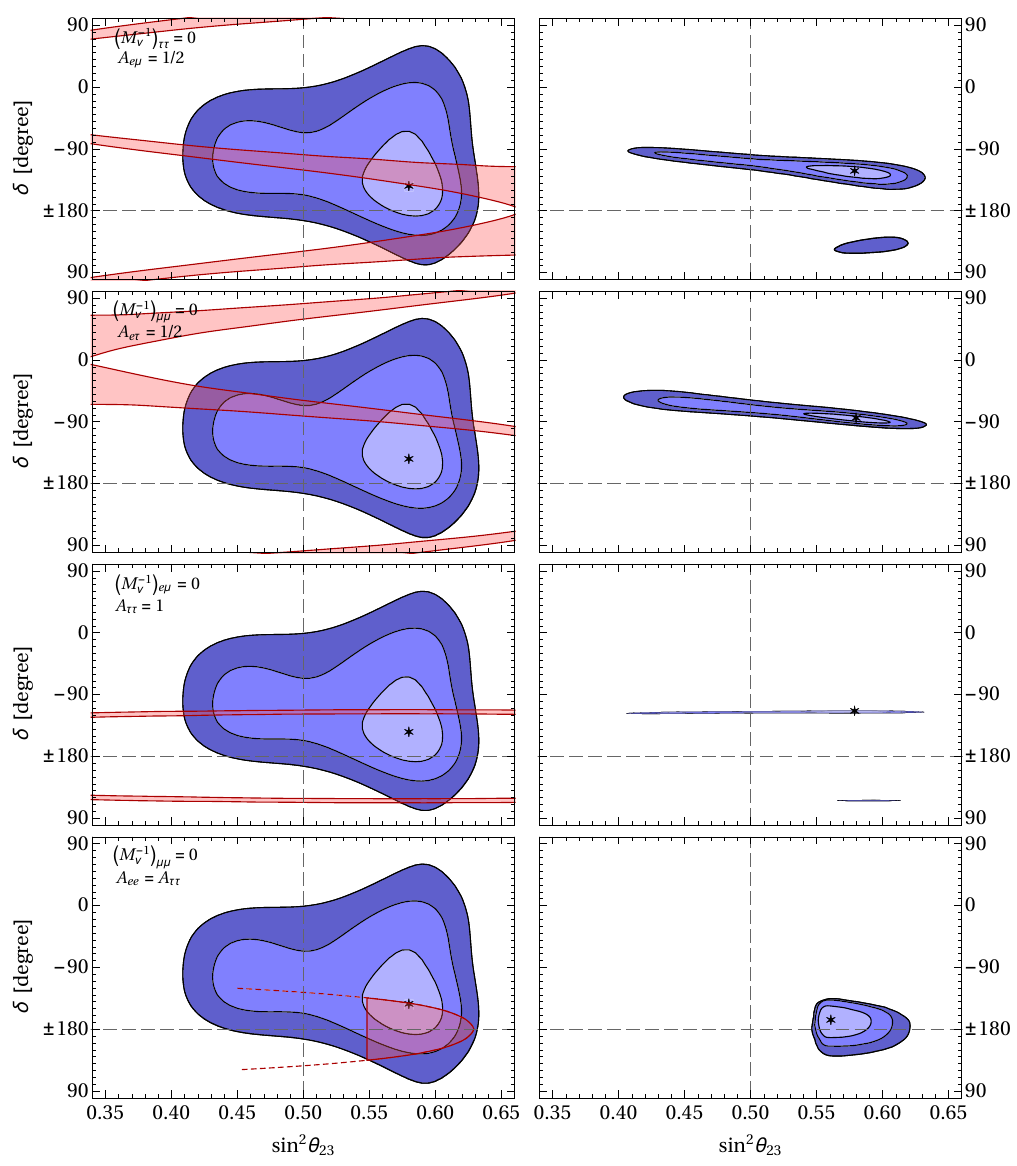
Figure 1 . Left panels: the predictions of each model with normal ordering (NO) of the neutrino masses, and the phenomenologically allowed areas for NO, are displayed in pink and blue colours, respectively. In the fourth row, the conditions of model 4 are obeyed in the whole area surrounded by the red line (which might be further extended to lower values of sin 2 (cid:18) 23 ), but P m (cid:23) obeys the cosmological bound (4.5) only in the pink area. Right panels: in di(cid:11)erent shades of blue, the 1 (cid:27) , 2 (cid:27) , and 3 (cid:27) regions de(cid:12)ned by the simultaneous compliance with the model conditions and the phenomenological data. In the fourth row, only the region satisfying the cosmological bound has been depicted. The stars mark the best-(cid:12)t points. Dashed lines at (cid:14) = (cid:25) and s 2 drawn just for orientation. More details are given in subsection 4.2.